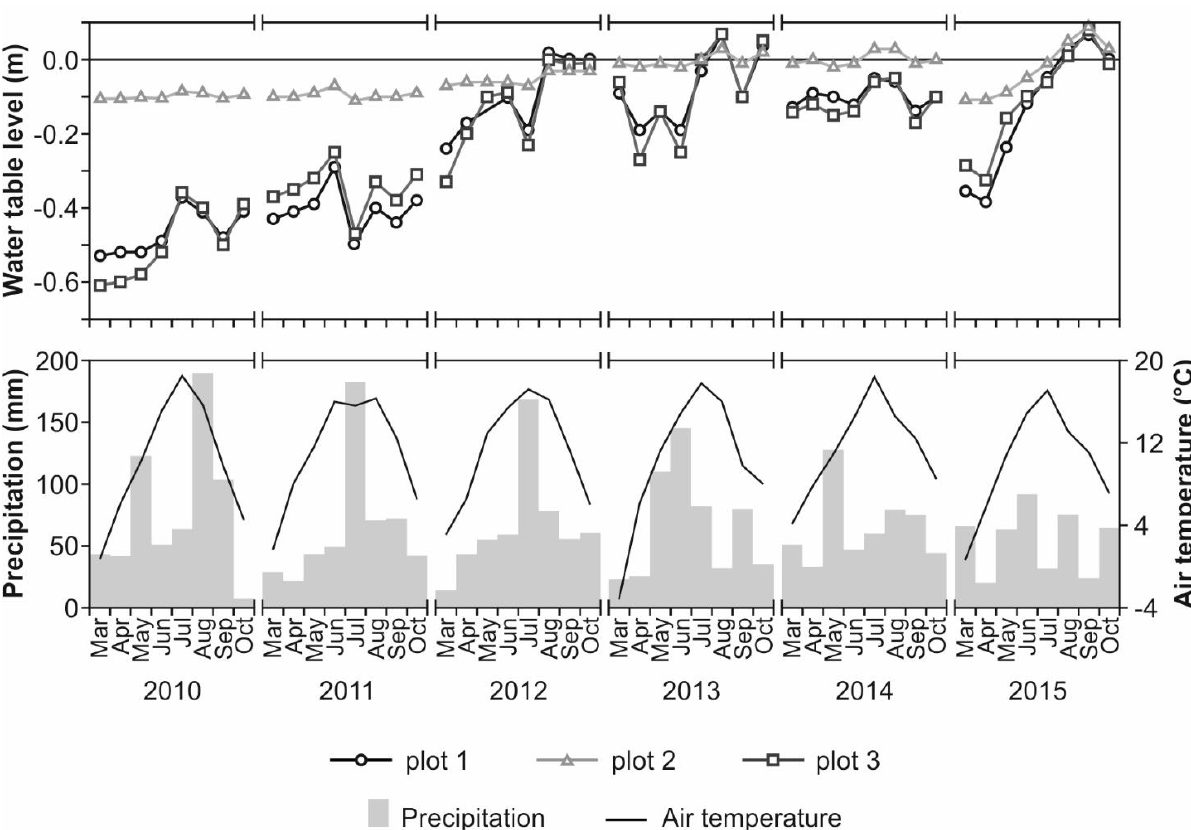
Figure 3. Weather conditions (temperature and precipitation) and water table level during the study period. Monthly precipitation amounts and mean monthly temperature were obtained from meteorological stations at Słoszów and Kudowa Zdrój,